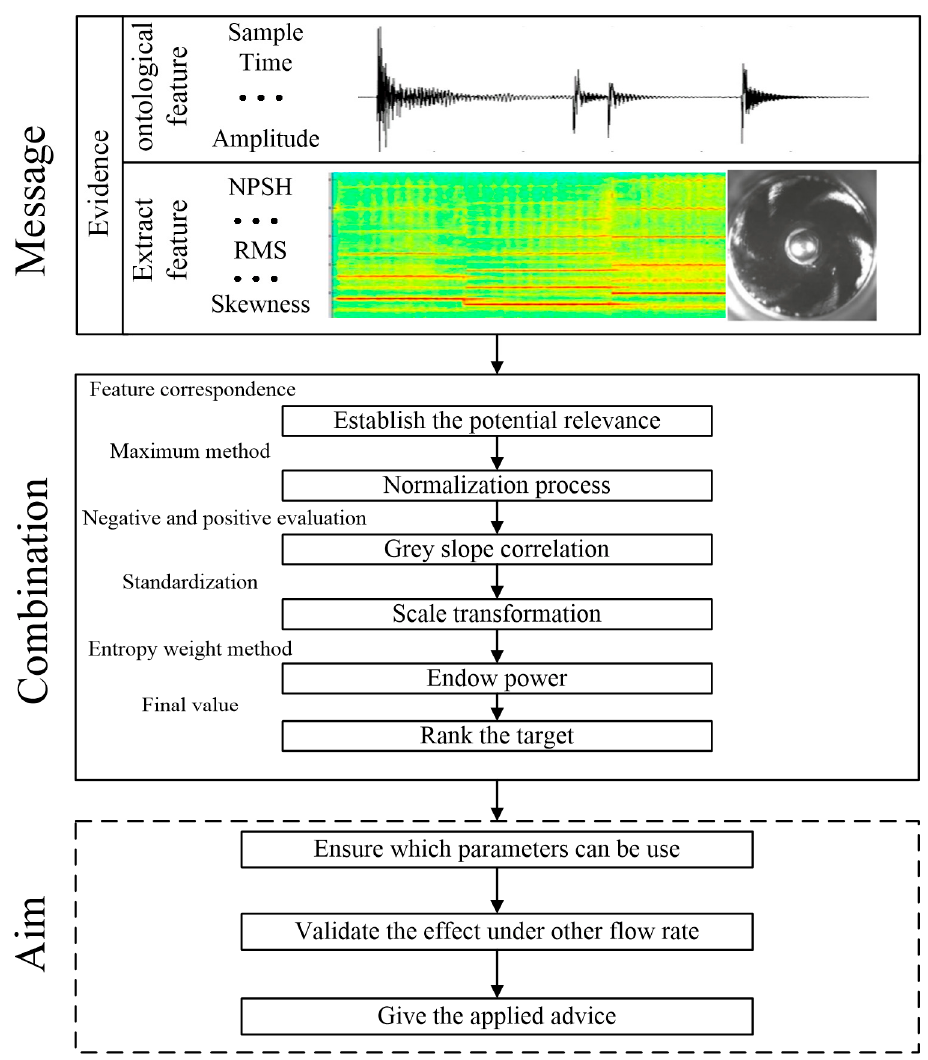
Figure 1. Flow chart of process.